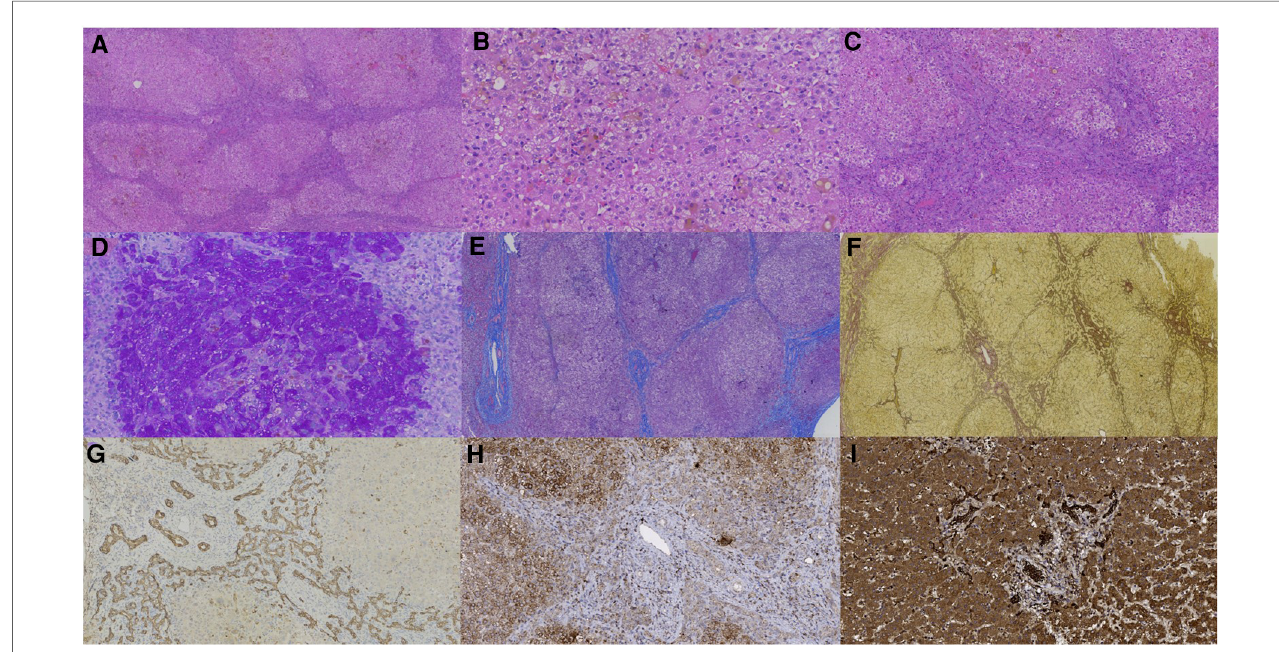
FIGURE 1 Liver biopsy (all originally magni fi ed principal images). Hematoxylin and eosin staining showed the discorded architecture of liver lobules and the formation of pseudo-lobules ( A ×40), balloon-like hepatic cells, giant cell changes of hepatocytes and bile plugs formation in hepatocytes and capillary bile ducts ( B × 200), and ductular proliferation, moderate portal-tract in fl ammation, and fi brosis in the portal area ( C ×100). PAS staining identi fi ed small vacuoles in partial hepatocytes ( D ×200). Formation of bridging-like fi brosis and pseudo-lobule was highlighted by Masson staining ( E ×50). The preserved reticular scaffold structure was displayed by reticulin staining ( F ×40). Obvious hyperplasia of bile ducts along the margins of pseudo-lobule was showed by immunohistochemical staining of CK7 ( G ×100). DCDC2 immunohistochemical staining showed weaker expression in patient 1 ( H ×200) than in normal control ( I